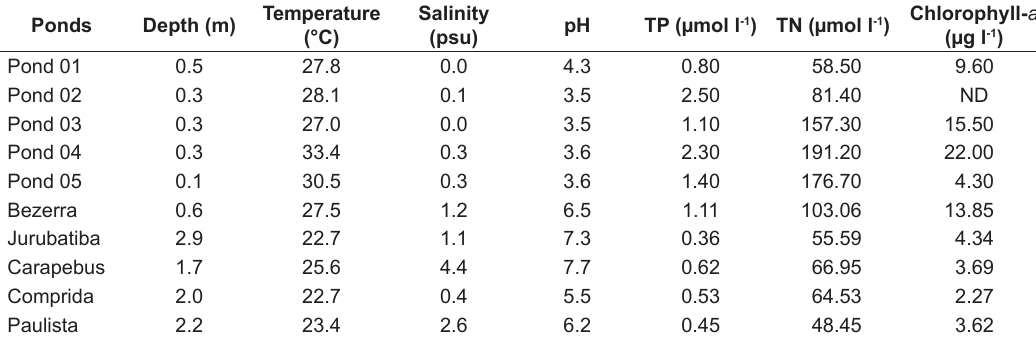
Table 2. Mean values of abiotic characteristics of ponds and lagoons located within Restinga de Jurubatiba National Park, Rio de Janeiro, Brazil: depth, temperature, salinity, pH, chlorophyll- a water concentration, water total nitrogen (NT) and water total phosphorus